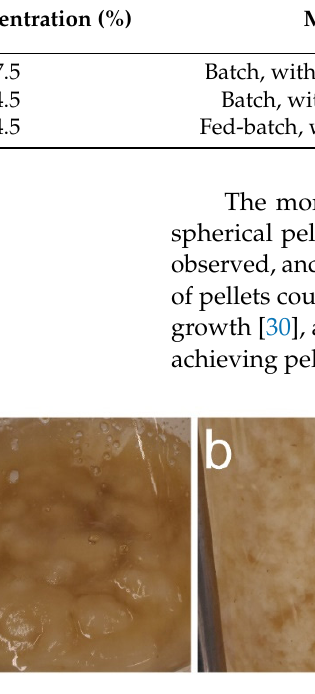
Figure 5. Photos of the morphology of the biomass in the ( a ) shake flasks, ( b ) 4.5 L bioreactor, and ( c ) 26 L bioreactor. ( d ) Picture of the biomass from the 26 L reactor captured with the oCelloscope to show the fungal microfibers.